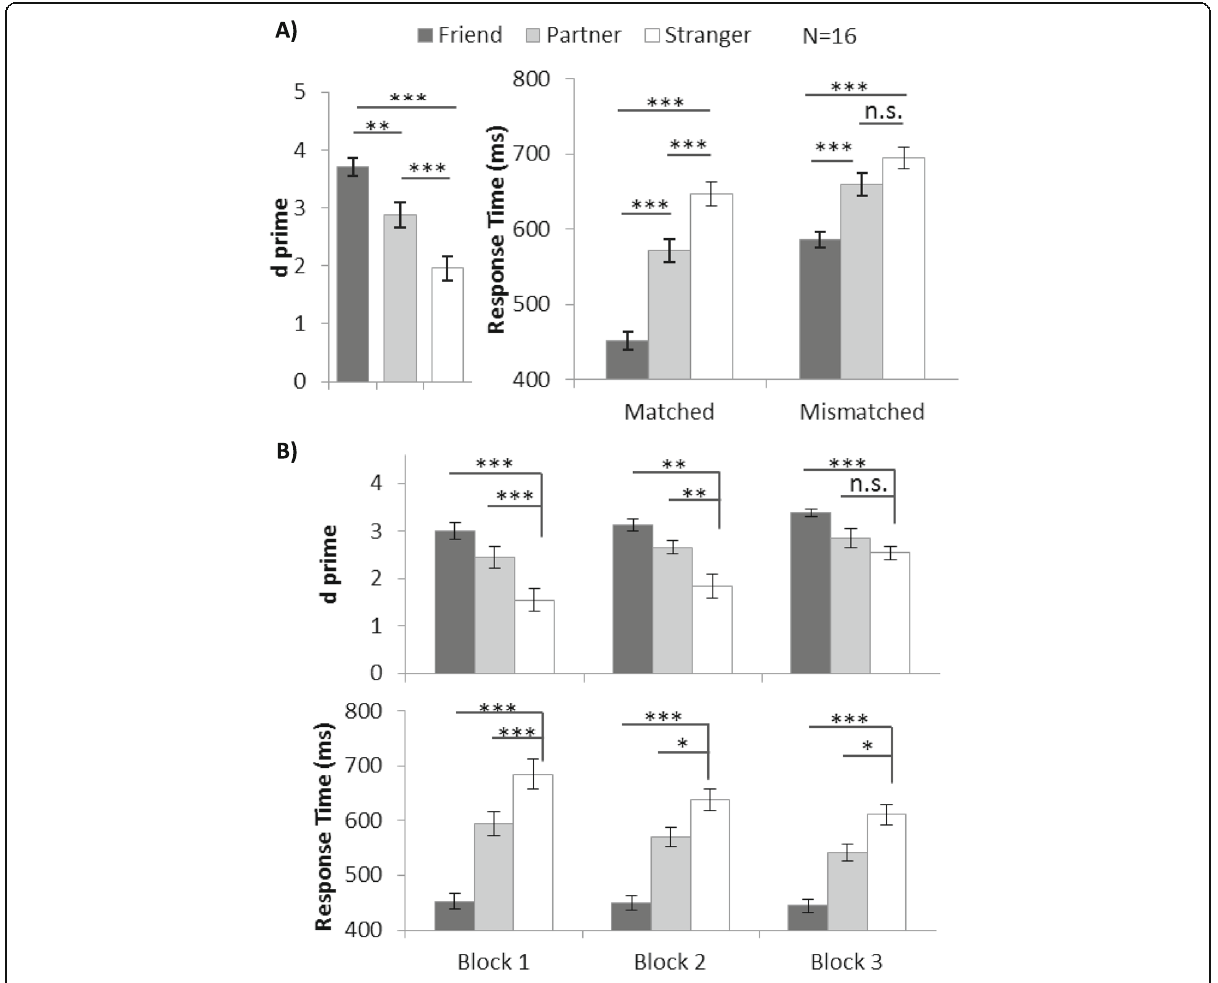
Fig. 5 a Mean and SE of d prime ( d ’ ) for different shape categories in experiment 4. b Mean and SE of d ’ and response time (RT) (matched trials) for different shape categories for each block in experiment 4. (* p < .05, ** p < .01, *** p < .001). n.s., not